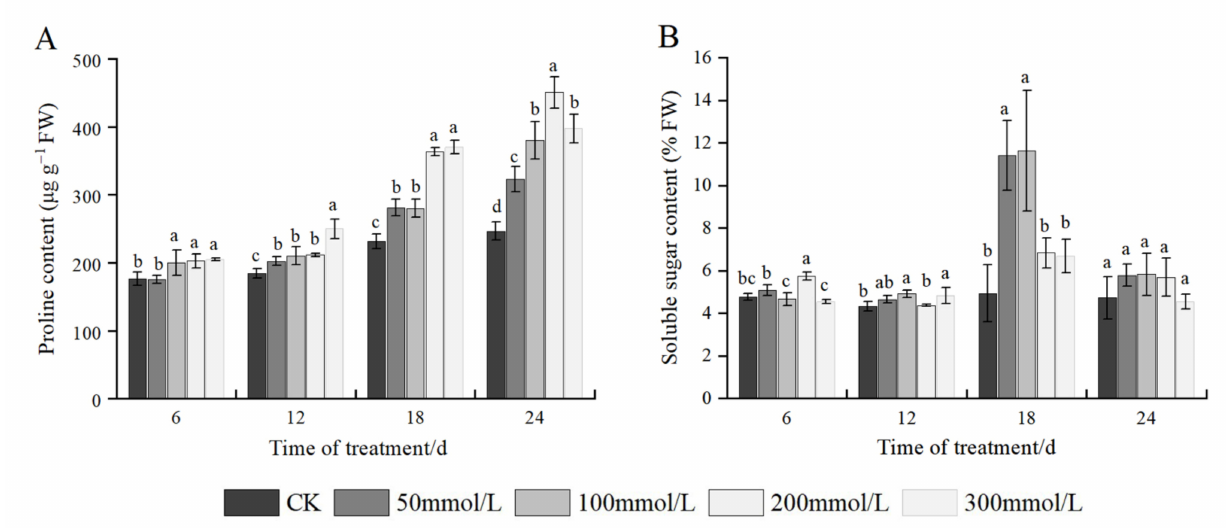
Figure 4. Effect of salt stress on osmotic adjustment substances of J. microcarpa L. seedlings. ( A ) Proline (Pro) content, ( B ) soluble sugar (SS) content in the leaves. Error bars indicate the SD of treatment means. Different letters on the bars indicate significant differences among the treatments ( p <